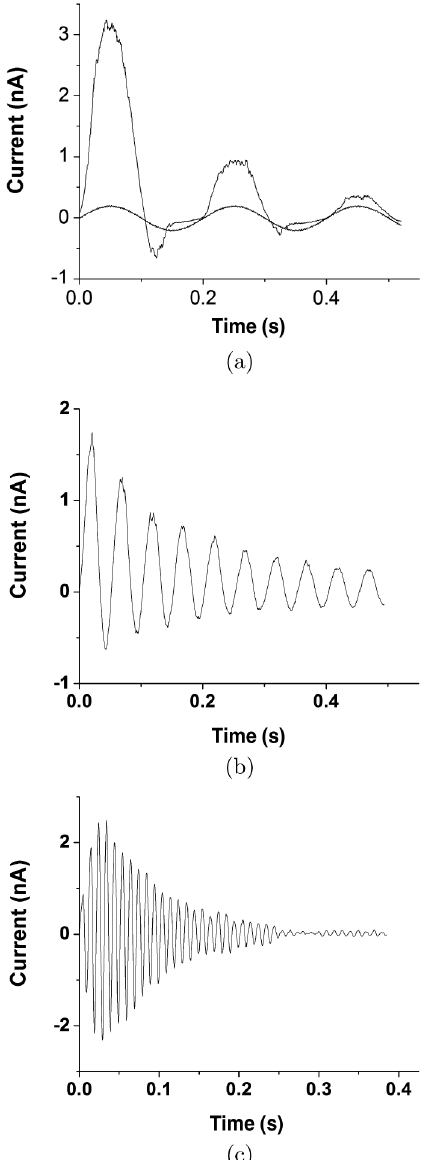
FIG. 9. Typical current traces from multichannel recordings ( N (cid:4) 100 ) for ac input signals at different frequencies. The three graphs were recorded from different bilayers, with symmetric salt conditions of 150-mM KCl. (a) 5-Hz signal at 70-mV rms amplitude; the applied sinusoidal voltage is plotted on the same graph. (b) 20-Hz signal at 50-mV rms amplitude. At these relatively low frequencies, the positive and negative current swings are asymmetric, reflecting the dc open-probability curve in Fig. 2. (c) 100-Hz signal at 50-mV rms. The envelope of the oscillations first rises, corresponding to the stochastic opening of the channels, then decreases to near zero due to the inactivation process. At these relatively high frequencies, the positive and negative current swings are symmetric.